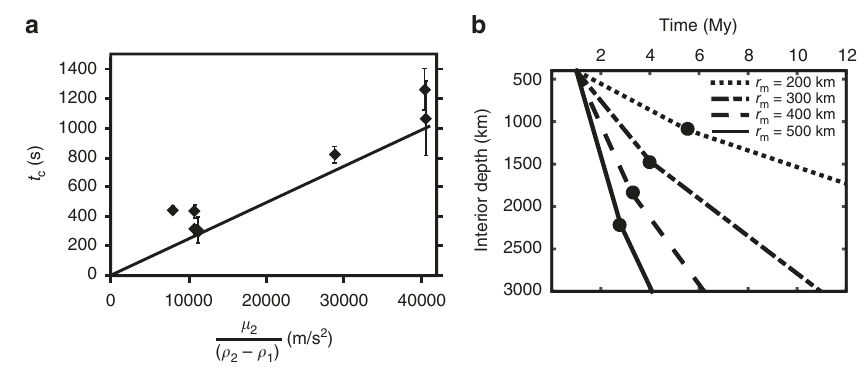
Fig. 7 Conduit stability. a Conduit constriction time for seven experiments which vary μ 2 . Constriction time, t c (see Results), is de fi ned by the time interval from the opening of a conduit when a diapir is fully formed ( R start ) to the time when the conduit radius stops changing after the metal diapir reaches the base of the tank base (Fig. 2d). Solid line shows theoretical prediction, t c , for a smooth metal diapir. b Theoretical prediction for diapir descent time versus conduit constriction time 18 ( fi lled circles) for diapir radii ( r m ) 200 – 500 km using Eqs. (2) and (5) and previous theoretical analysis 18 . Each line represents the descent of a diapir in time and distance from the base of the magma ocean to the CMB after onset of the metal pond instability (assuming ρ 1 = 2850 kg/m 3 , ρ 2 = 4500 kg/m 3 , μ 2 = 10 23 Pa ⋅ s, average h c = 300 km, and θ = 55°). Filled black circles indicate the time for conduit collapse for each diapir. An average onset time, t onset of 1.0 My is used for a 1 km deep metal pond. Increasing t onset will only prolong fi nal diapir descent times but does not change the depth to which conduits stay open, as conduit constriction times are referenced to the beginning of conduit formation after t onset . Conduit radius, represented by θ , reduces drag around a diapir and is one of the most important factors controlling the depth of conduit closure showing that conduits stay open to deeper depths for increasing θ and higher ρ 1 . Constriction times, t c , are multiplied by 2, consistent with our laboratory observations (Fig. 7a). Once the conduit closes, diapirs are assumed to descend according to classical Stokes velocity (slope change). Interior mantle depth is de fi ned from the base of a 400 km deep magma ocean. The total times estimated for metal plume descent and thermochemical plume ascent is 2 – 60 My for μ 2 ranging from 10 19 to 10 23 Pa ⋅ s (see Supplementary Fig. 3), diapir radius of 500 km, and a soliton radius of 50